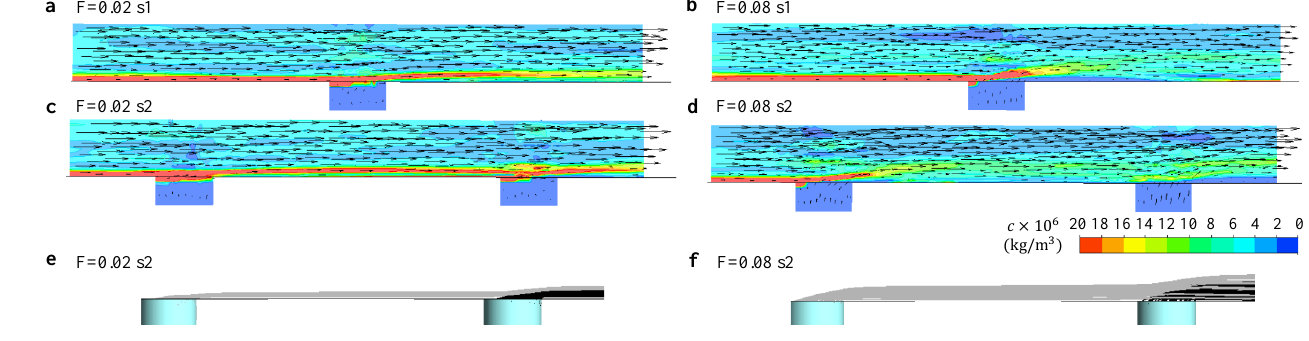
Figure 9. The velocity field and concentration contour in y − z cross section along s1 or s2 at different blowing ratios: ( a ) F = 0.02-s1, ( b ) F = 0.08-s1, ( c ) F = 0.02-s2, and ( d ) F = 0.08-s2. The streamline of the cooling air originated from two cooling holes along s2 for ( e ) F = 0.02 and ( f ) F = 0.08. The streamline from the first hole is colored in grey, while that from second one is colored in